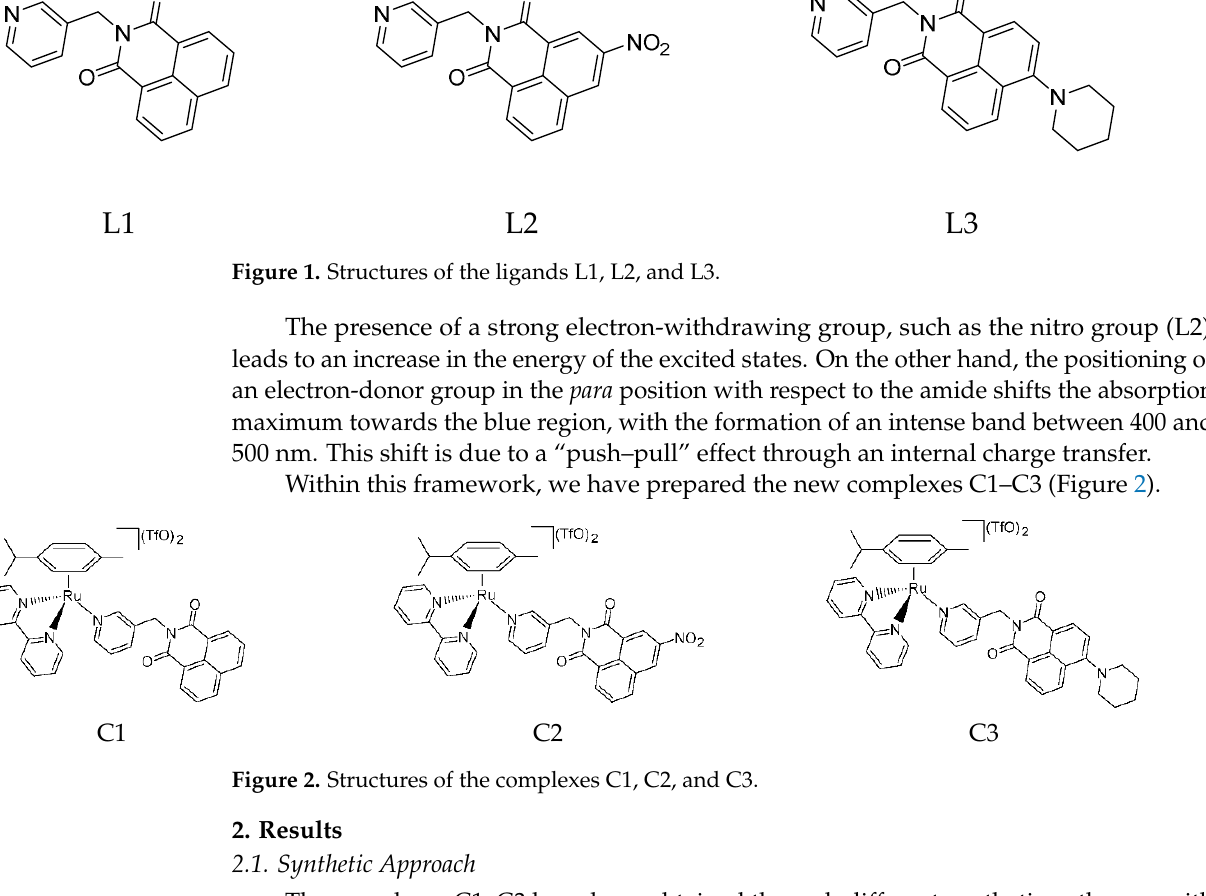
Figure 2. Structures of the complexes C1, C2, and C3.